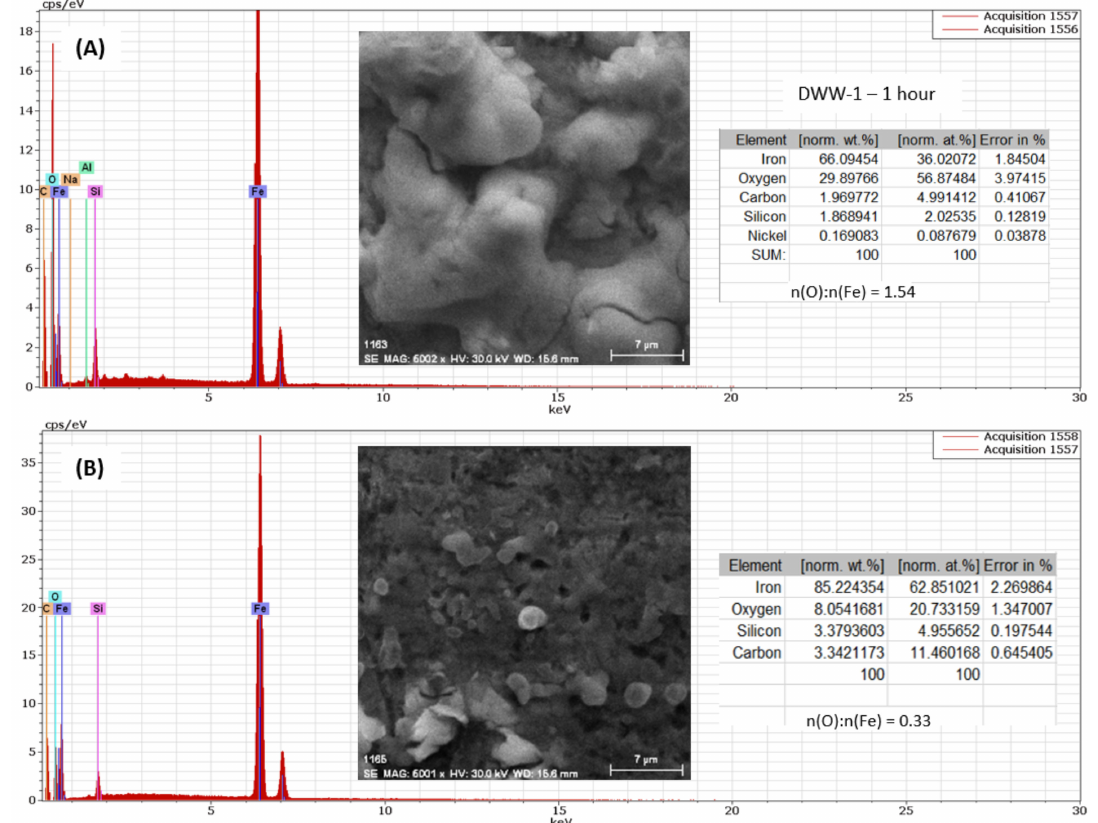
Figure 7. Chemical compositions and EDS spectra for the sample immersed for 1 h in DWW-1, ( A ) Zone A and ( B ) Zone B.